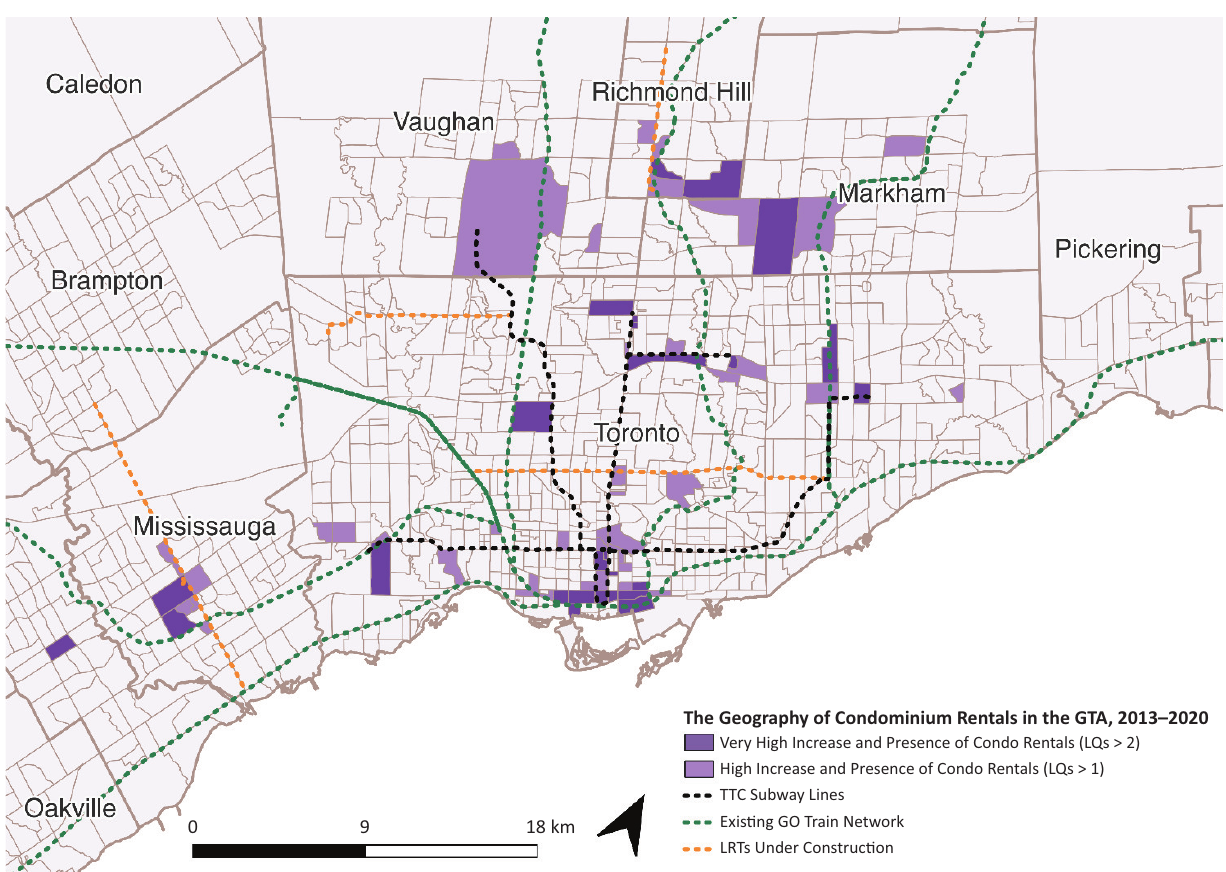
Figure 7. The geography of condo rental concentration in the GTA, 2013–2020. Notes: TTC refers to the Toronto Transit Commission subway system. The GO Train is the Government of Ontario commuter rail system. LRT stands for Light Rail Transit. Source: Created by the authors using custom tabulated census tract level data provided by CMHC (2020a).